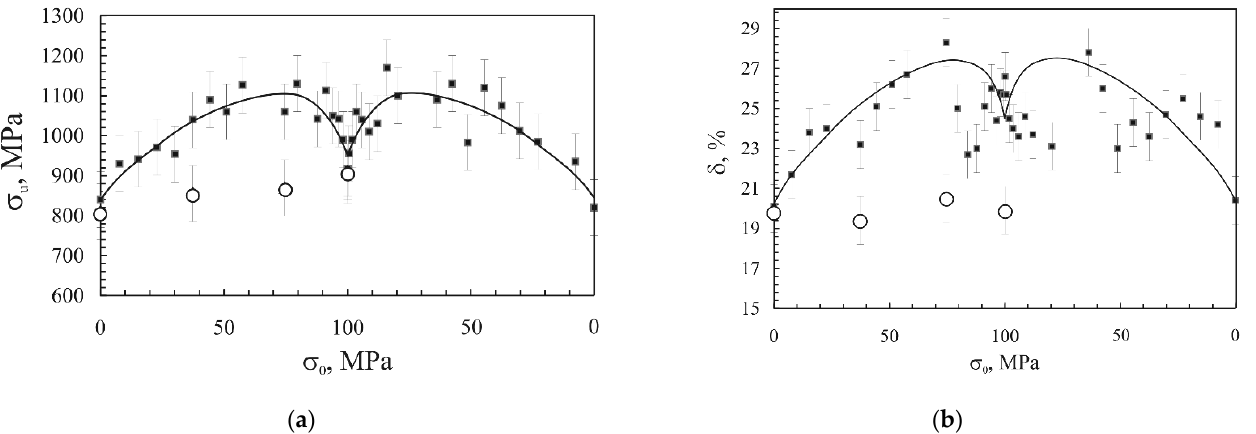
Figure 14. Dependencies of the ultimate strength ( a ) and elongation to failure ( b ) of ultrasonically irradiated nanostructured Ni on the amplitude of oscillating stresses. The solid lines give the trends of the changes in characteristics. Open circles are datum points for the non-sonicated ECAP Ni at the sample positions corresponding to four values of the stress amplitude in the sonicated sample [25].